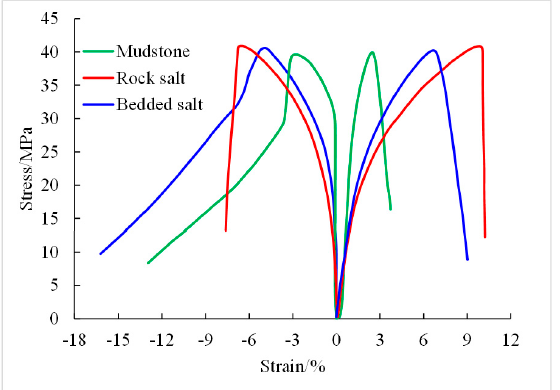
Figure 2. Stress ‐ strain curves of mudstone, rock salt and bedded salt in triaxial compression tests with confining pressure of 20 MPa, 25 MPa and 30 MPa. Table 1. Mechanical parameters of Pingdingshan rock